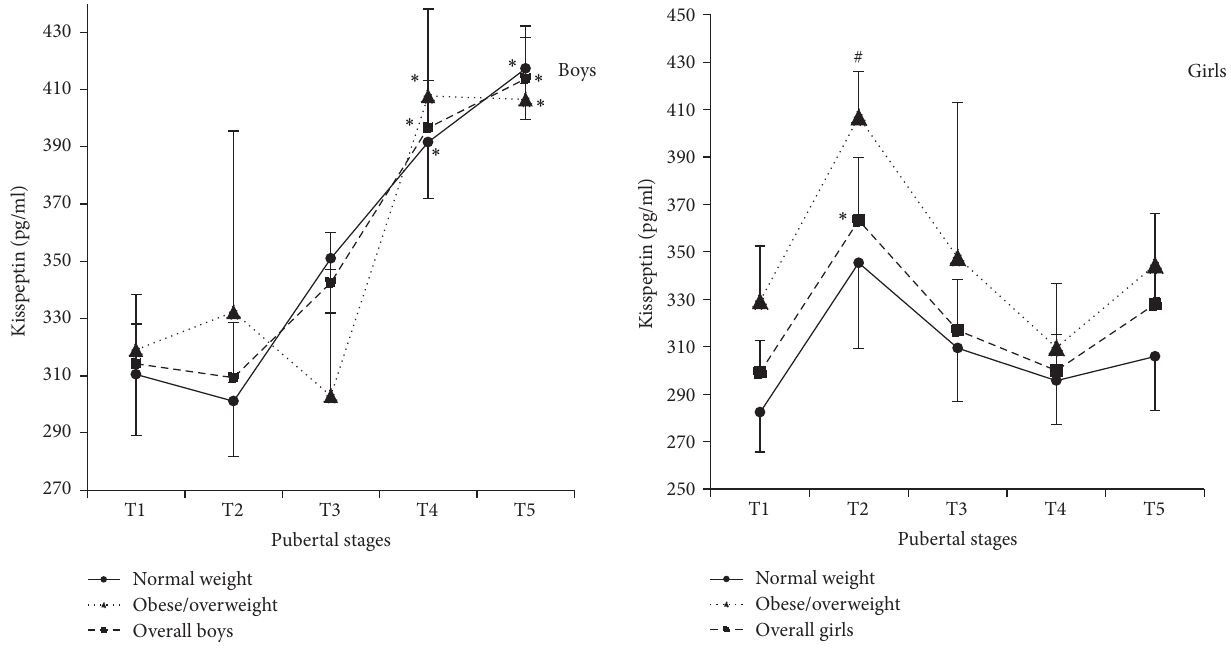
Figure 3: Serum kisspeptin levels of boys and girls in different pubertal stages (boys: ∗ compared with T1, 𝑃 < 0.05 ; girls: ∗ compared with T1 and T4, 𝑃 < 0.05 , and # compared with T1, T4, and T5, 𝑃 < 0.05 ).